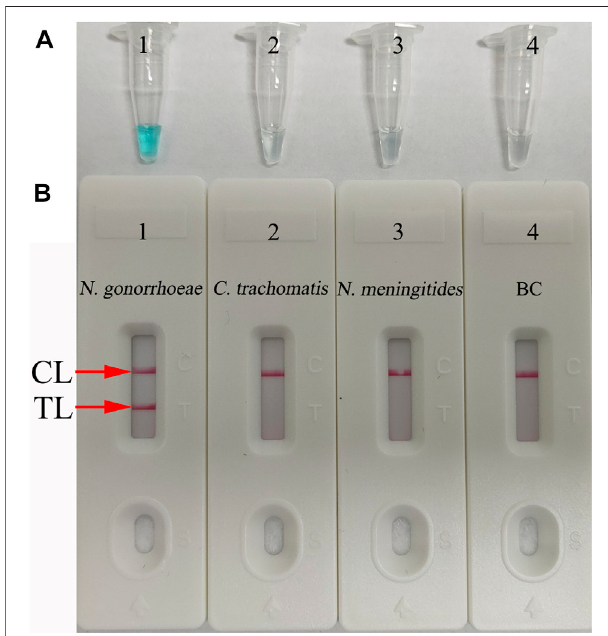
FIGURE 3 | Determination and con fi rmation of the N. gonorrhoeae - LAMP products. The N. gonorrhoeae -LAMP products were analyzed with the colorimetric indicator (A) and polymer nanoparticle – based biosensor (B) . Tube 1/Biosensor 1: positive results of the N. gonorrhoeae reference strain (ATCC 49926); Tube 2/Biosensor 2: negative results of Chlamydia trachomatis ; Tube 3/Biosensor 3: negative results of Neisseria meningitidis ; Tube 4/Biosensor 4: blank control (distilled water). TL: test line; CL: control line.